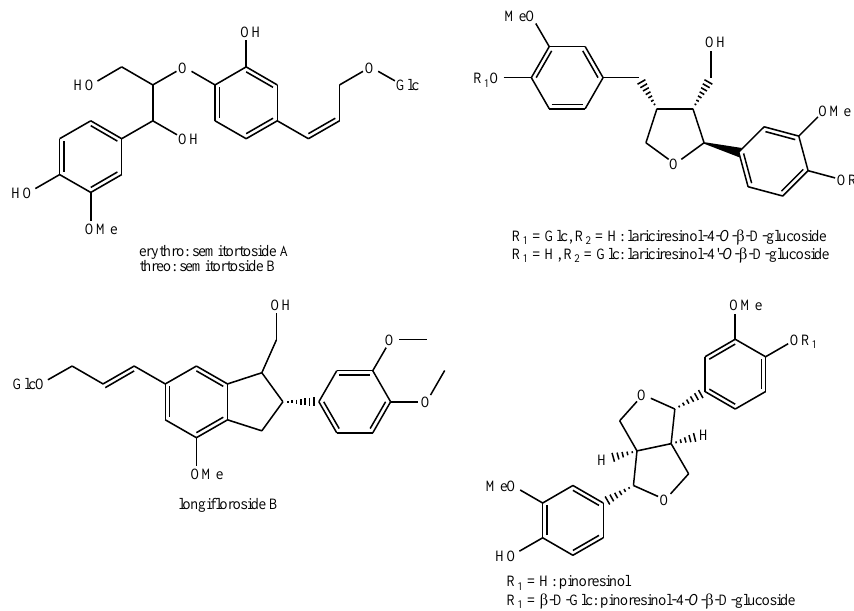
Figure 7. Lignans and neo -lignans identified in Pedicularis species—part 1. Plants 2019 , 8 , x FOR PEER REVIEW